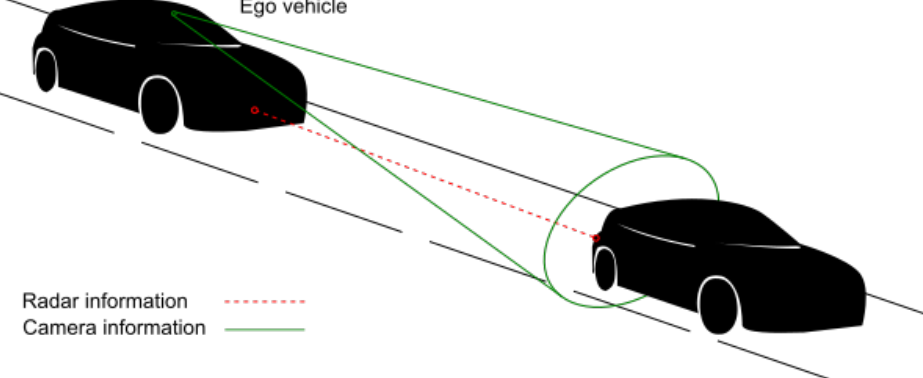
Figure 1. Concept of using camera feed in addition to radar feed in adaptive cruise